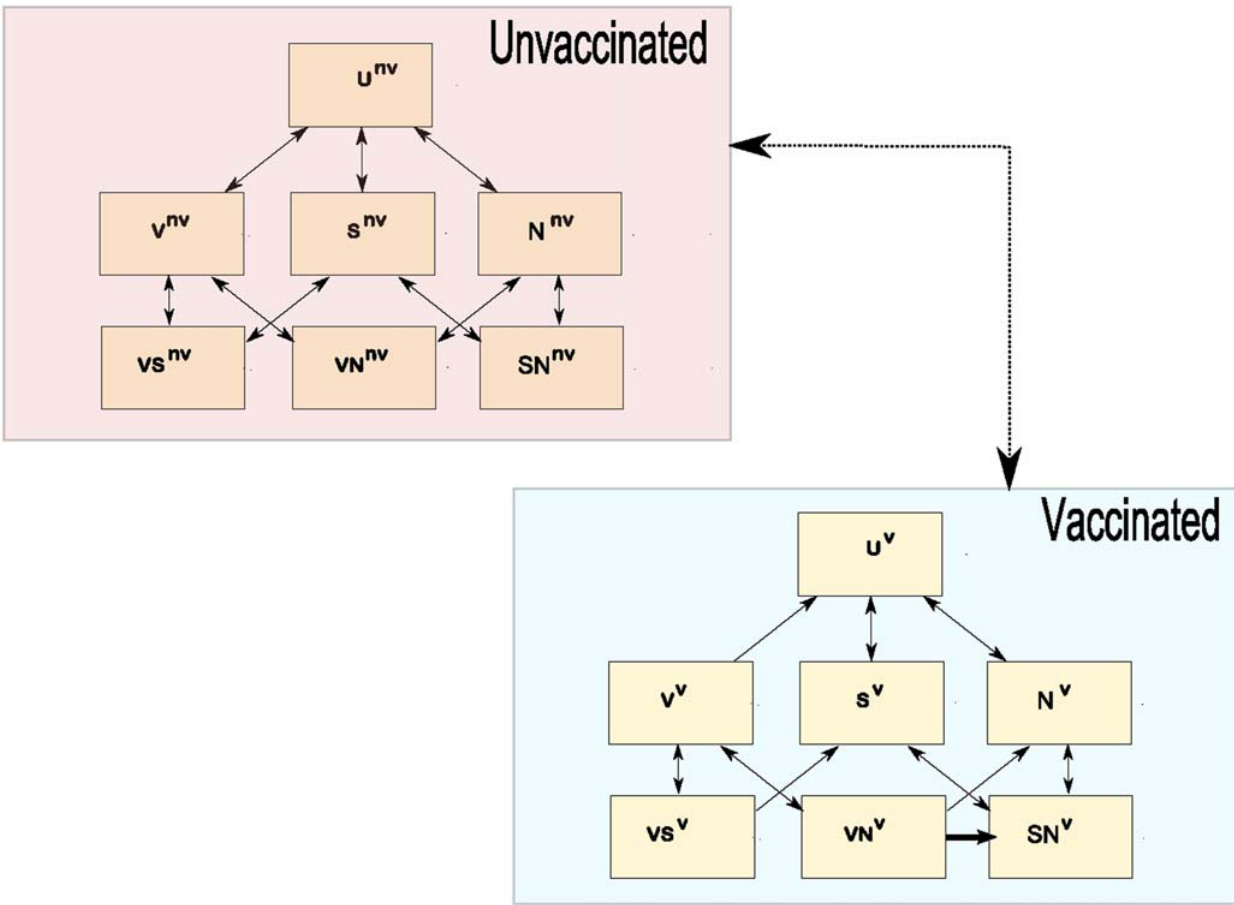
Figure 1. Model Structure within one age class. Individuals can be either uncolonized (U), colonized with vaccine serotypes (V), non-vaccine serotypes resulting from the capsular switch of a vaccine serotype (S) or wild-type non-vaccine serotypes (N). Dual colonization is allowed (VS, VN or SN). The model is structured into two age classes (children and adults). A portion of children are vaccinated, and vaccination immunity may last into adulthood. Vaccinated individuals can only acquire colonization with non-vaccine-type pneumococci. Switch events may occur in vaccinated individuals colonized with both vaccine and non-vaccine serotypes (VN) and are depicted by a bold arrow.